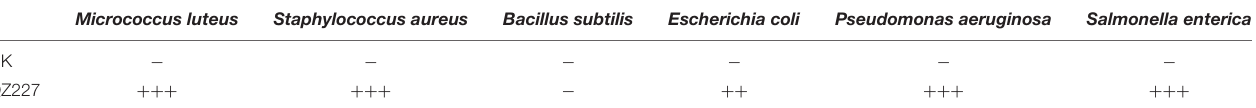
TABLE 1 | The pathogen inhibition of